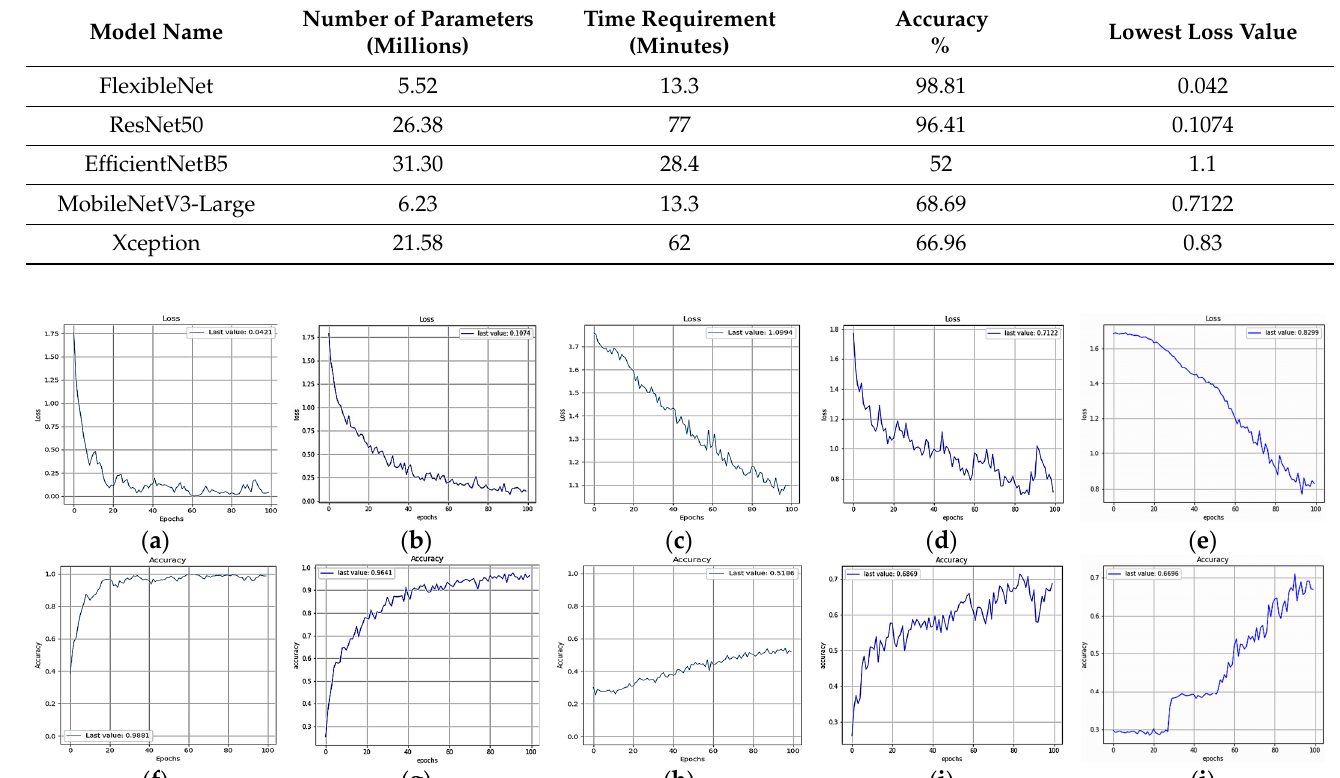
Table 4. Summary of the outcomes of the experiments using an image resolution of 32 × 32.